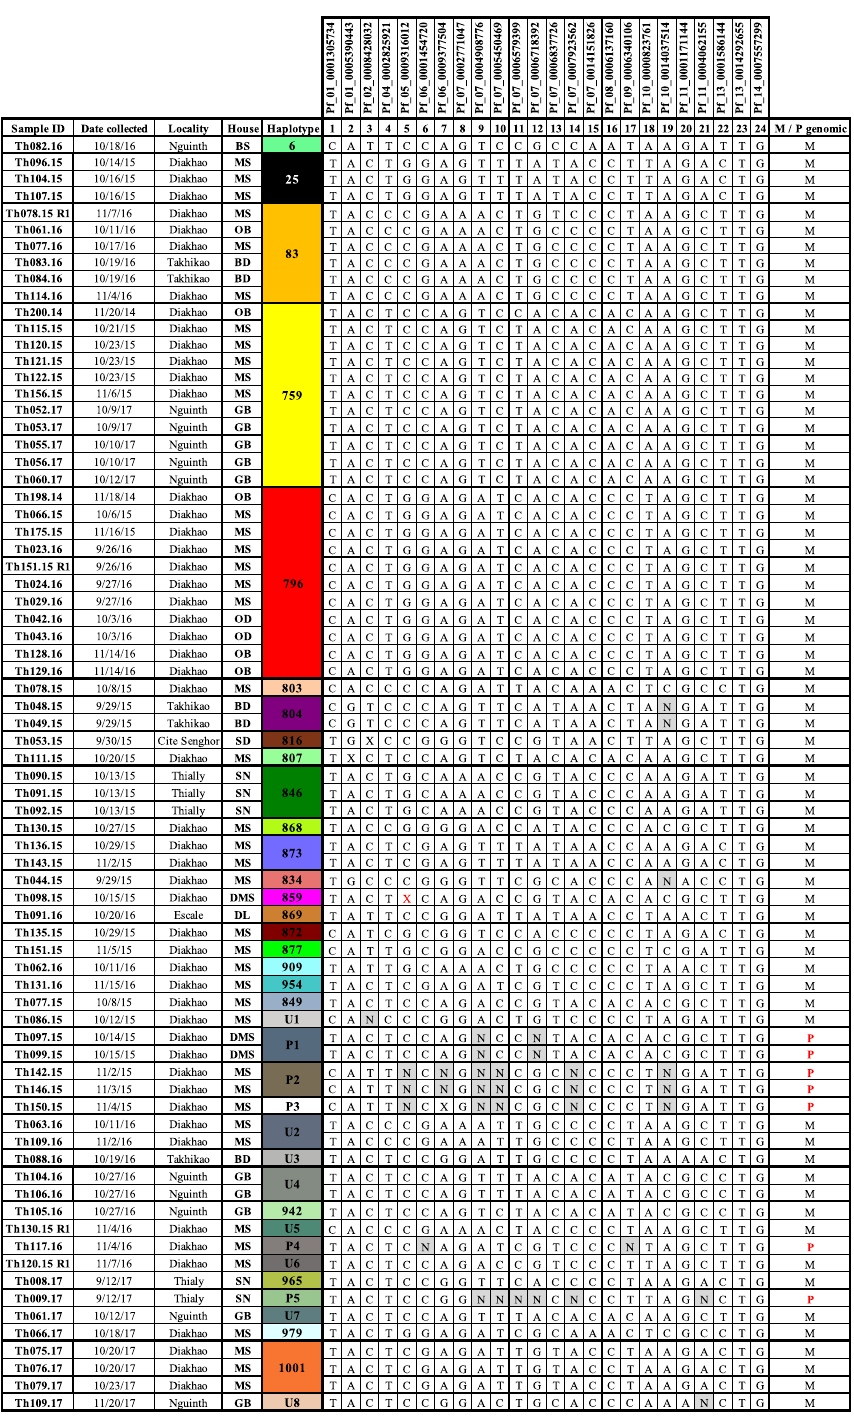
Figure 1. Barcodes of Plasmodium falciparum isolates identified in the study cohort. Barcoded parasites from the n = 70 participants in the longitudinal cohort followed for 24 months. Patient ID (human) is shown along with date of sampling, Age, Neighborhood, Household (arbitrary alphabetical code), and barcode haplotype. SNP positions are indicated for the 24-SNP barcode. “N” indicates a position with two peaks—corresponding to both biallelic SNPs (mixed genotype), and an “X” indicates a reproducibly negative call. M/P genomic indicates monogenomic (M) or polygenomic (P)